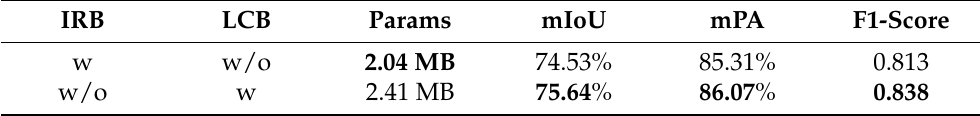
Table 5. The ablation study results for local contextual